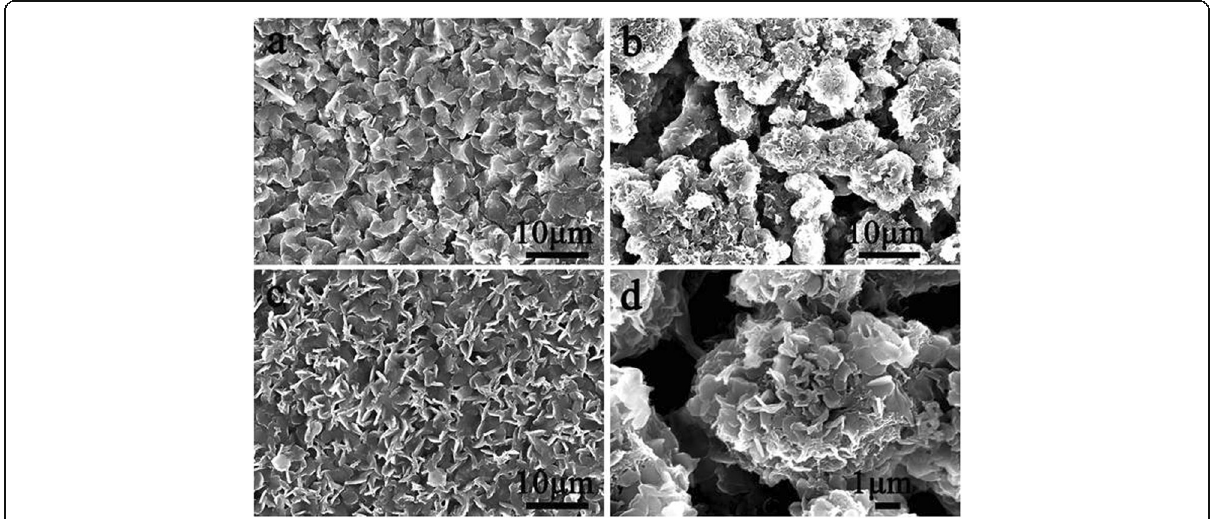
Fig. 3 SEM diagram of composite films at different polymerization times ( a ) 6 h, ( b ) 9 h, ( c ) 12 h, and ( d ) an enlarged view of 9 h